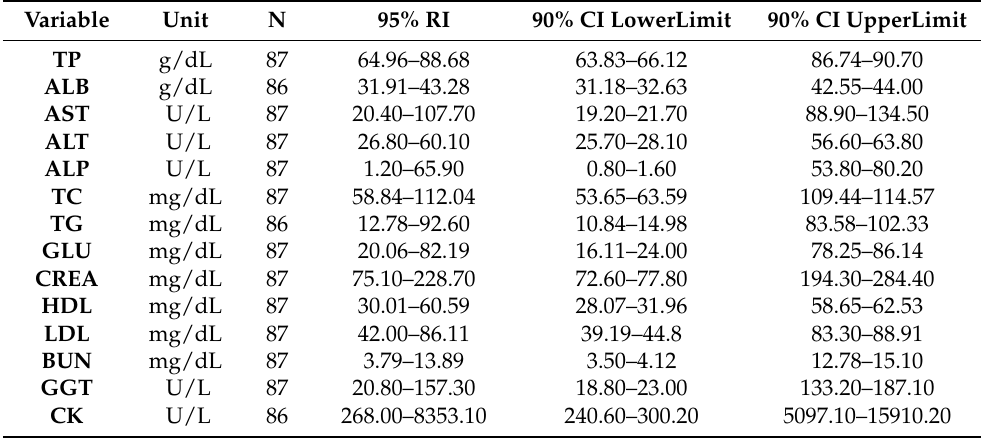
Table 6. Biochemical values and RIs for